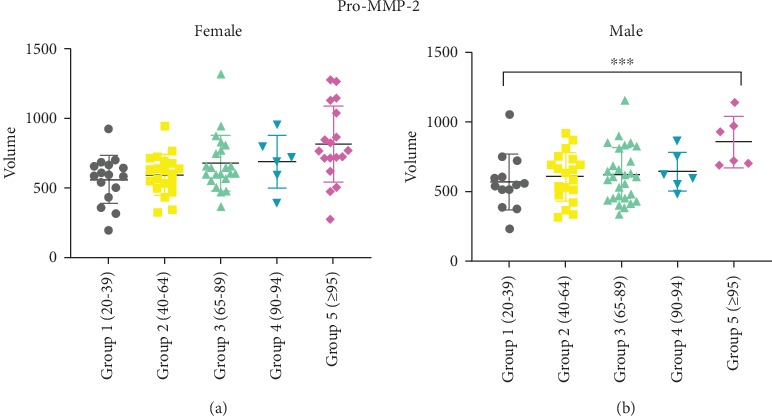
Scatter plot graphs of Pro-MMP-2 activity levels in female (a) and male (b) evaluated by gelatin zymography and grouped for age. The lines indicate mean and standard error. The densitometric analysis, performed by measuring the intensity levels of each band and the corresponding area, is referred as volume. Statistical analysis was performed applying the Kruskal–Wallis nonparametric test. ∗∗∗p < 0.001.